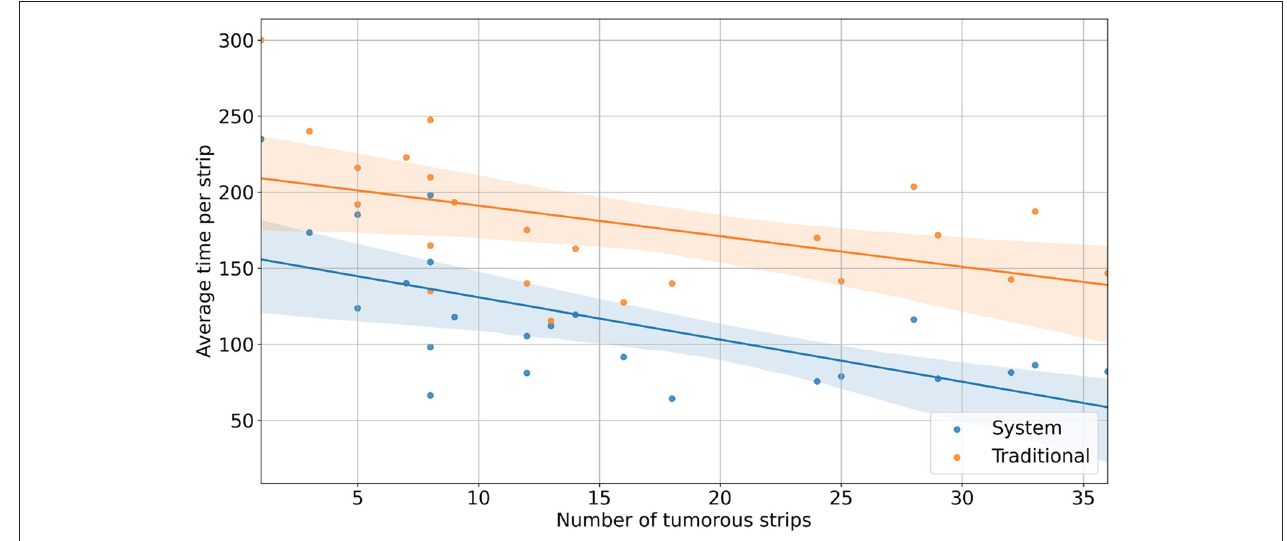
FIGURE 4 | Average strip diagnostic time vs. the number of tumorous strips.